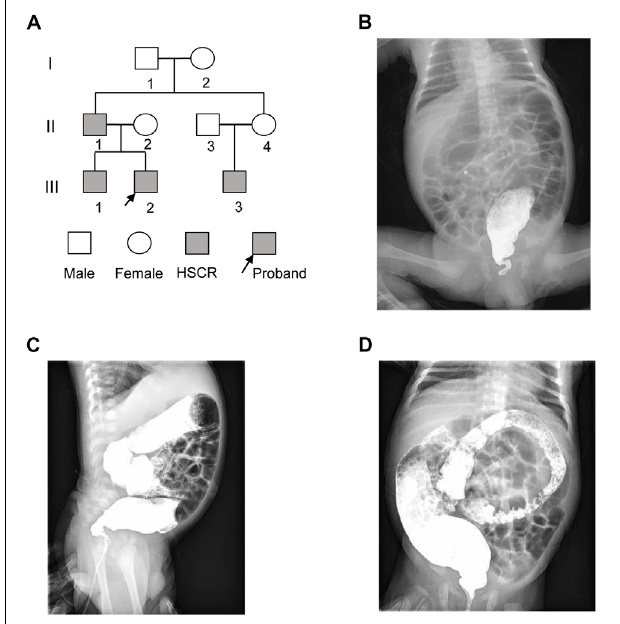
FIGURE 1 | The pedigree of three generations of the HSCR family. (A) Pedigree of the three-generation, Chinese family with four affected individuals. Squares indicate males, and circles represent females. Black and white symbols represent affected and unaffected individuals, respectively. The proband is indicated by an arrow. (B–D) The colon X-ray images of the proband at three different